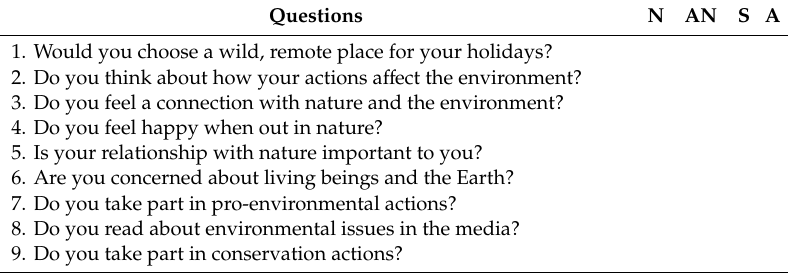
Table 3. Ad hoc questionnaire based on that developed by Nisbet and Zelenski (2013).